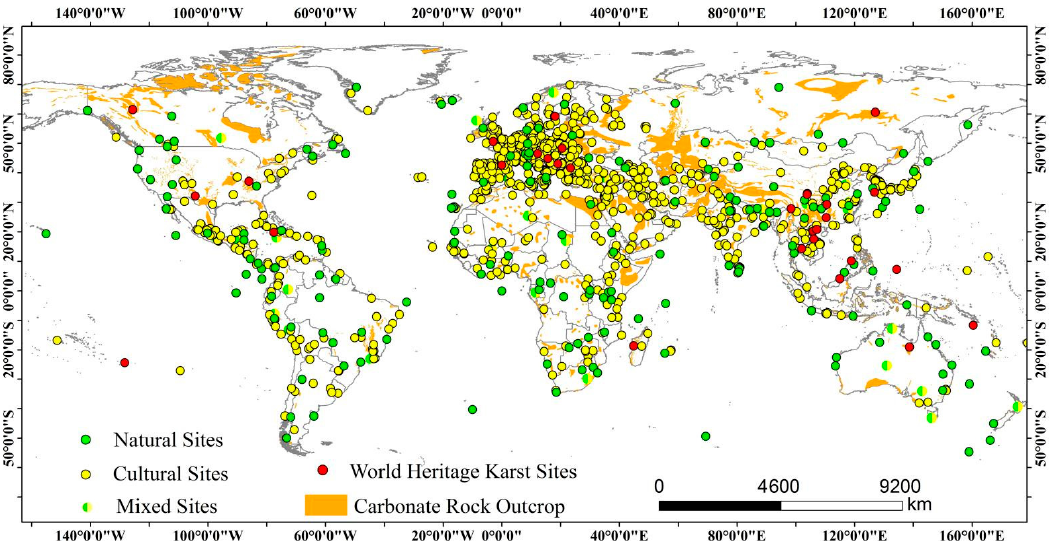
Figure 1. Global distribution of natural sites, cultural sites, mixed sites, and WH karst sites.